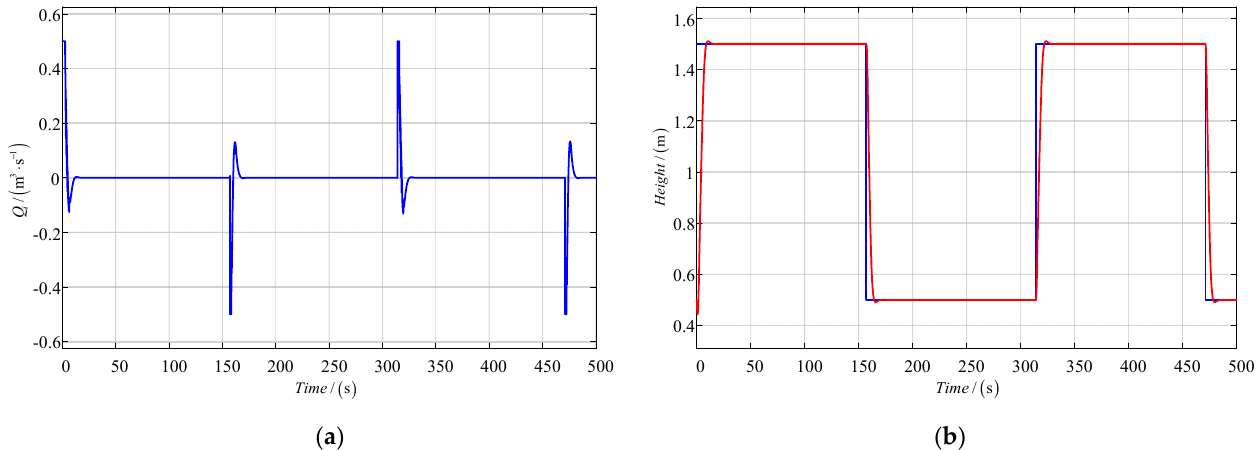
Figure 9. Simulation results of nonlinear feedback (0.4): ( a ) represents the control input curve ( b ) represents the water curve. level